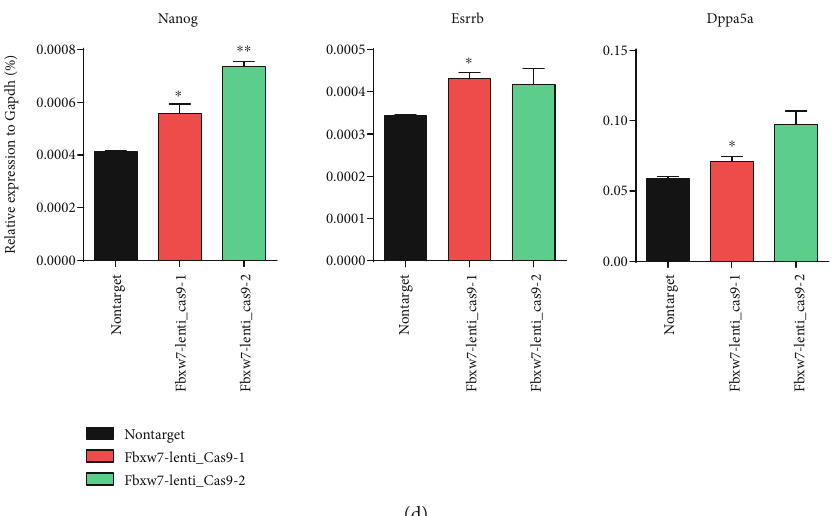
Figure 4: RT-qPCR analysis of the three pluripotency factors ’ expression in wild-type OG2 mESCs transfected with lenti-Cas9-sgRNA of (a) Tcf7l1, (b) p53, (c) Jarid2, and (d) Fbxw7 and treated by withdrawing 2i/LIF. The error bar represents standard error, ∗ P < 0 : 05 , ∗∗ P < 0 : 01 , ∗∗∗ P < 0 : 001 vs.